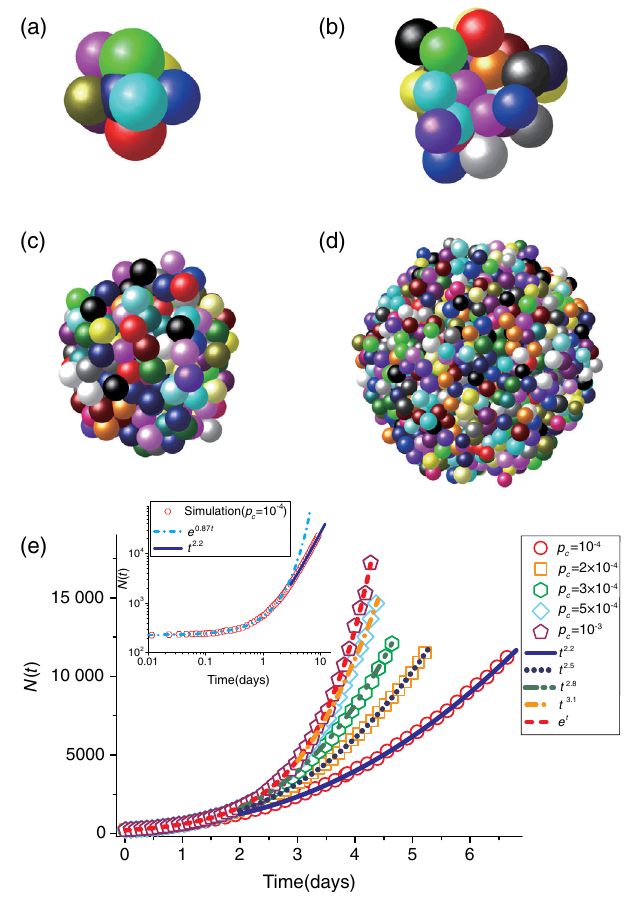
FIG. 4. Dynamics of tumor growth. (a) – (d): Instantaneous snapshots of the tumor during growth at different times. Each cell is represented by a sphere. There are approximately 2000 cells in (d). The color of each cell is to aid visualization. In (a) – (d), the cell sizes are rescaled for illustration purposes only. Note that, even at t ¼ 0 (a), the sizes of the cells are different because they are drawn from a Gaussian distribution. (e): The total number of tumor cells N ð t Þ as a function of time at different values of the threshold pressure p , which increases from bottom c to top ( 10 − 4 , 2 × 10 − 4 , 3 × 10 − 4 , 5 × 10 − 4 , 10 − 3 MPa). The dashed red line is an exponential function, while the other lines show power-law behavior N ð t Þ ≈ t β , where β ranges from 2.2 to 2.5, 2.8, and 3.1 (from bottom to top). The inset in (e) shows N ð t Þ 10 − 4 on a log-log scale with both exponential and with p c ¼ power-law fits. The dashed-dotted curve in the inset is an exponential function, while the power-law trend is illustrated by 54 000 s,and thesolidline.Theaveragecellcycletime τ ¼ τ min ¼ the other parameter values are taken from Table